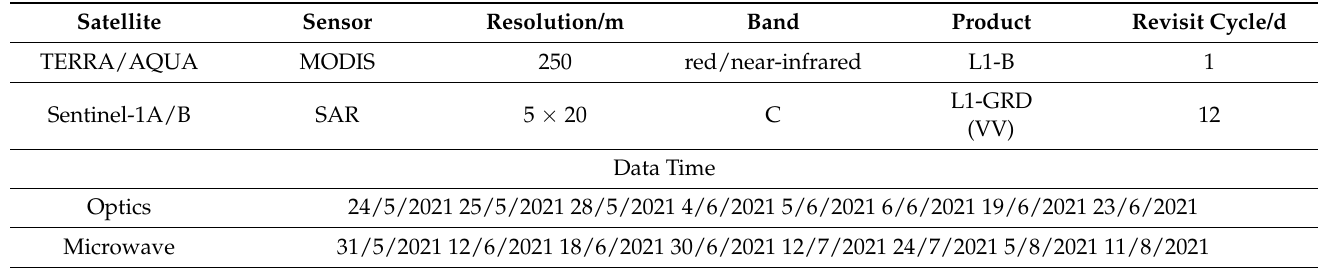
Figure 1. The study area (red rectangle showing the area of green tide). Table 1. Main data sources and